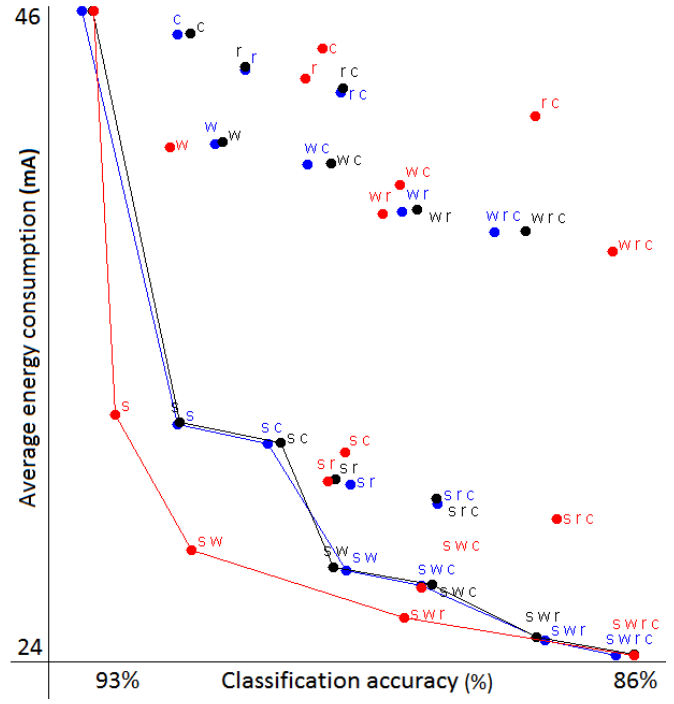
Figure 2. The black points are the real trade-offs; the blue points are simulated with Markov chains; and the red points are simulated with the naive model. The Pareto fronts are drawn using the corresponding colors. The points are labeled with letters that correspond to the activities where the low frequency was used: w, walking; r, running; c, cycling; s, rest. Note that the Pareto front is usually drawn with step-shaped lines, but we connected points directly for greater clarity. The red Pareto front might look the best, but this is a consequence of overly optimistic estimation, not of better